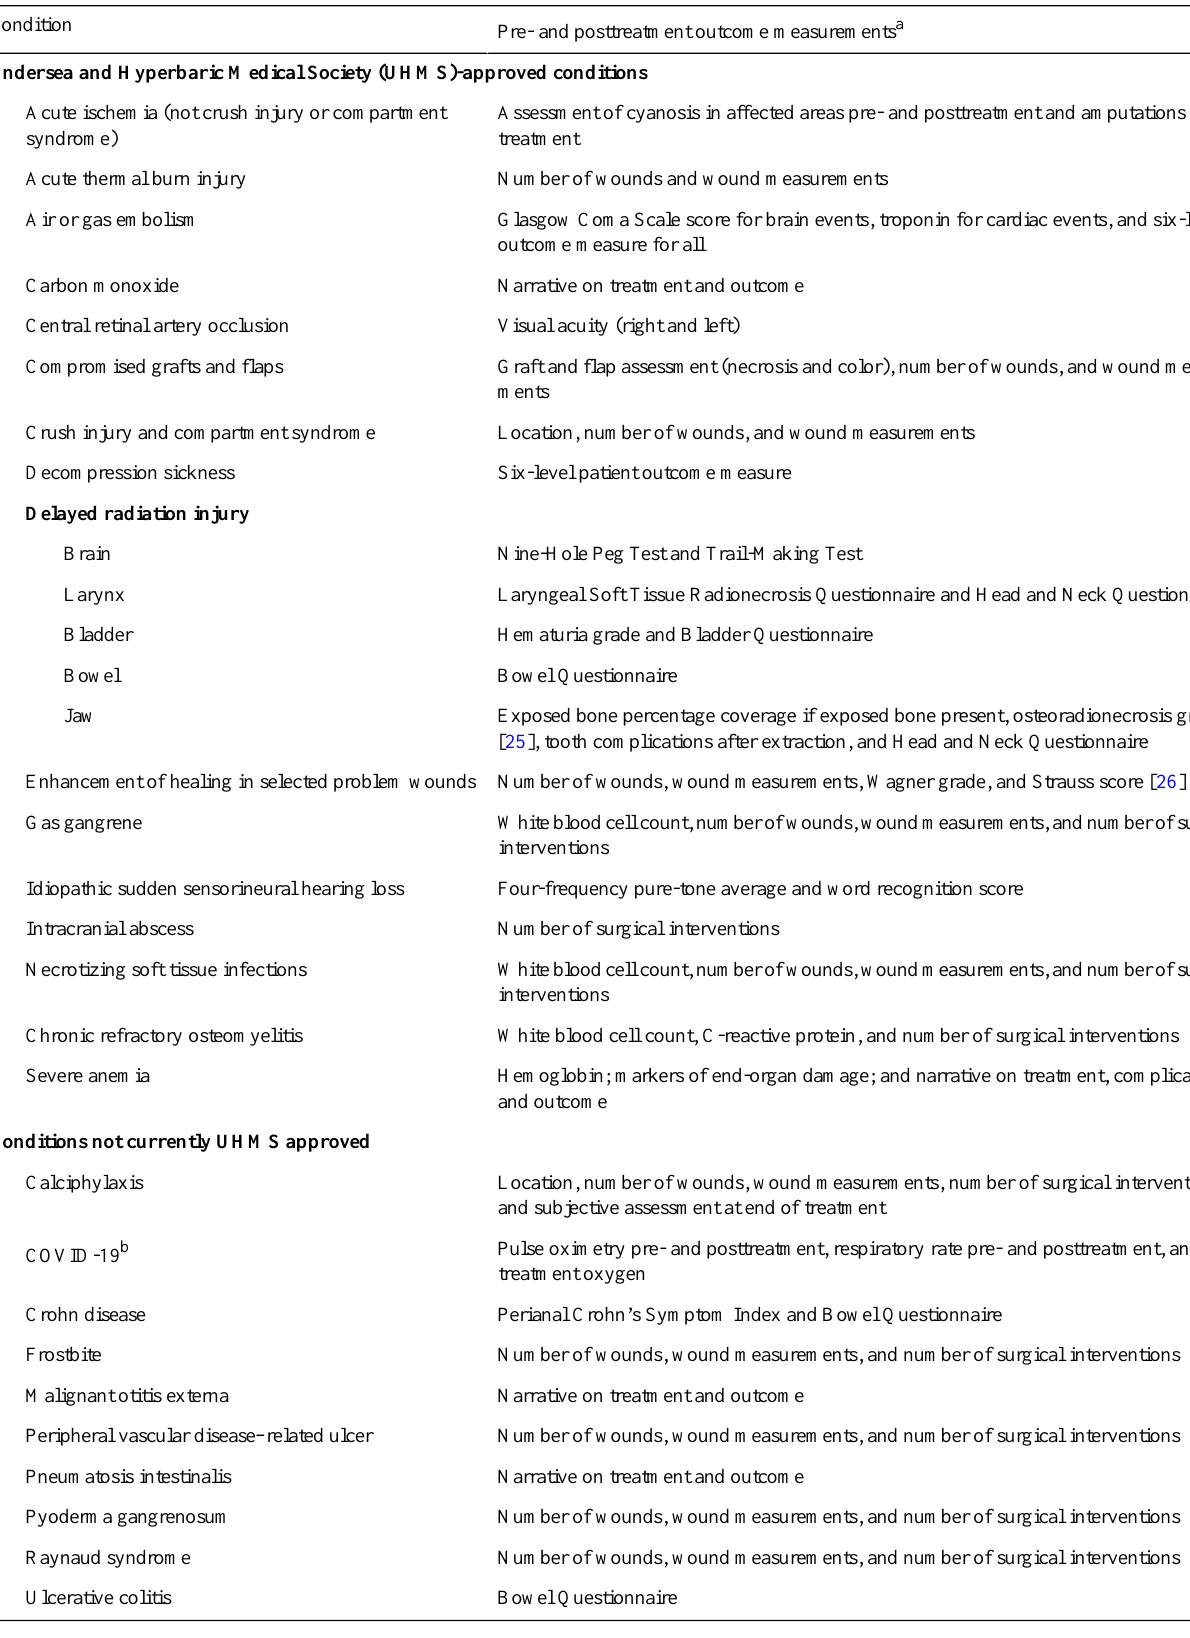
Table 3. Indications for hyperbaric oxygen (HBO 2 ) treatment and outcomes measured for the